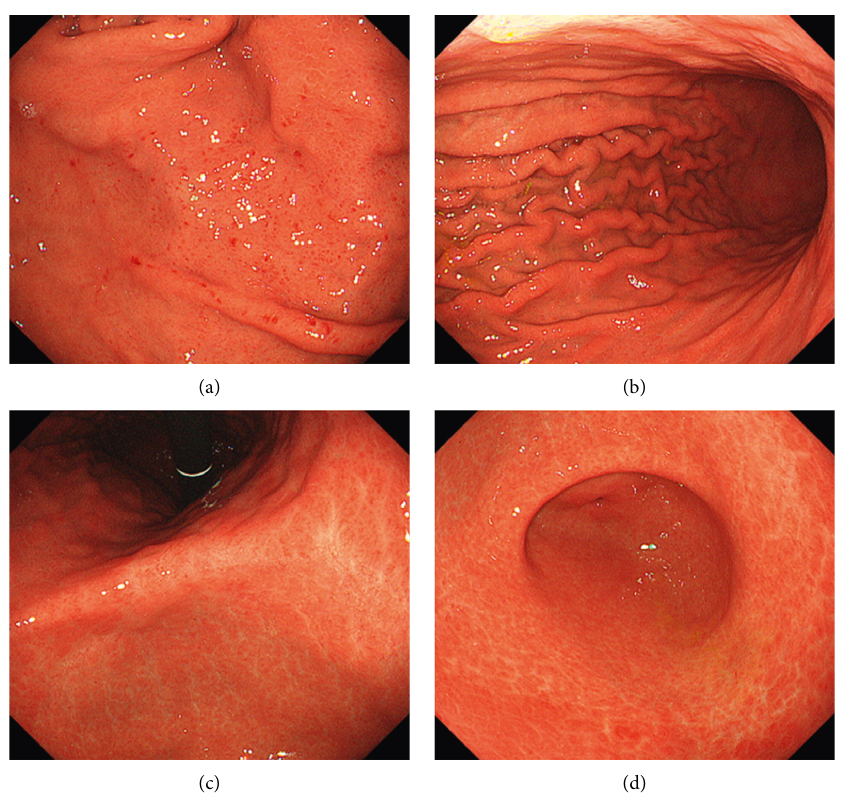
Figure 1: Esophagogastroduodenoscopy images. Endoscopy reveals spotty redness at the gastric fornix (a), mucosal swelling with diffuse redness in the corpus (b), and mucosal atrophy in the gastric angle (c) and antrum (d).